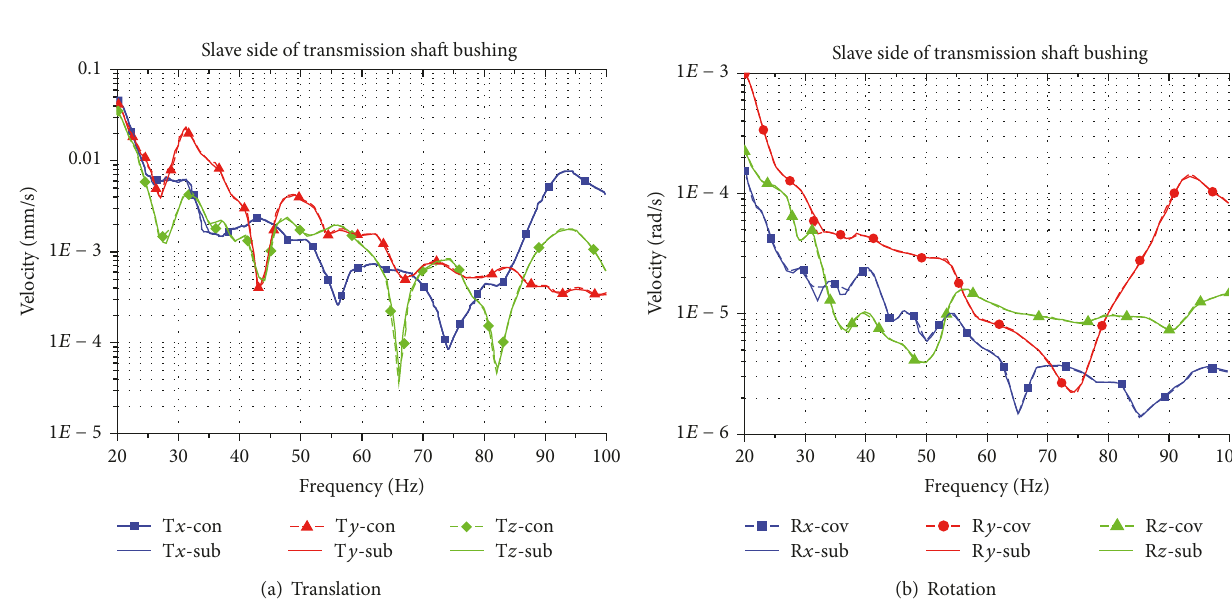
Figure 11: Velocity